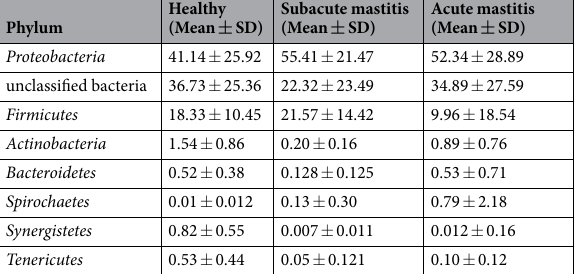
Table 1. Proportion of bacterial phyla detected in breast milk of healthy, SAM and AM